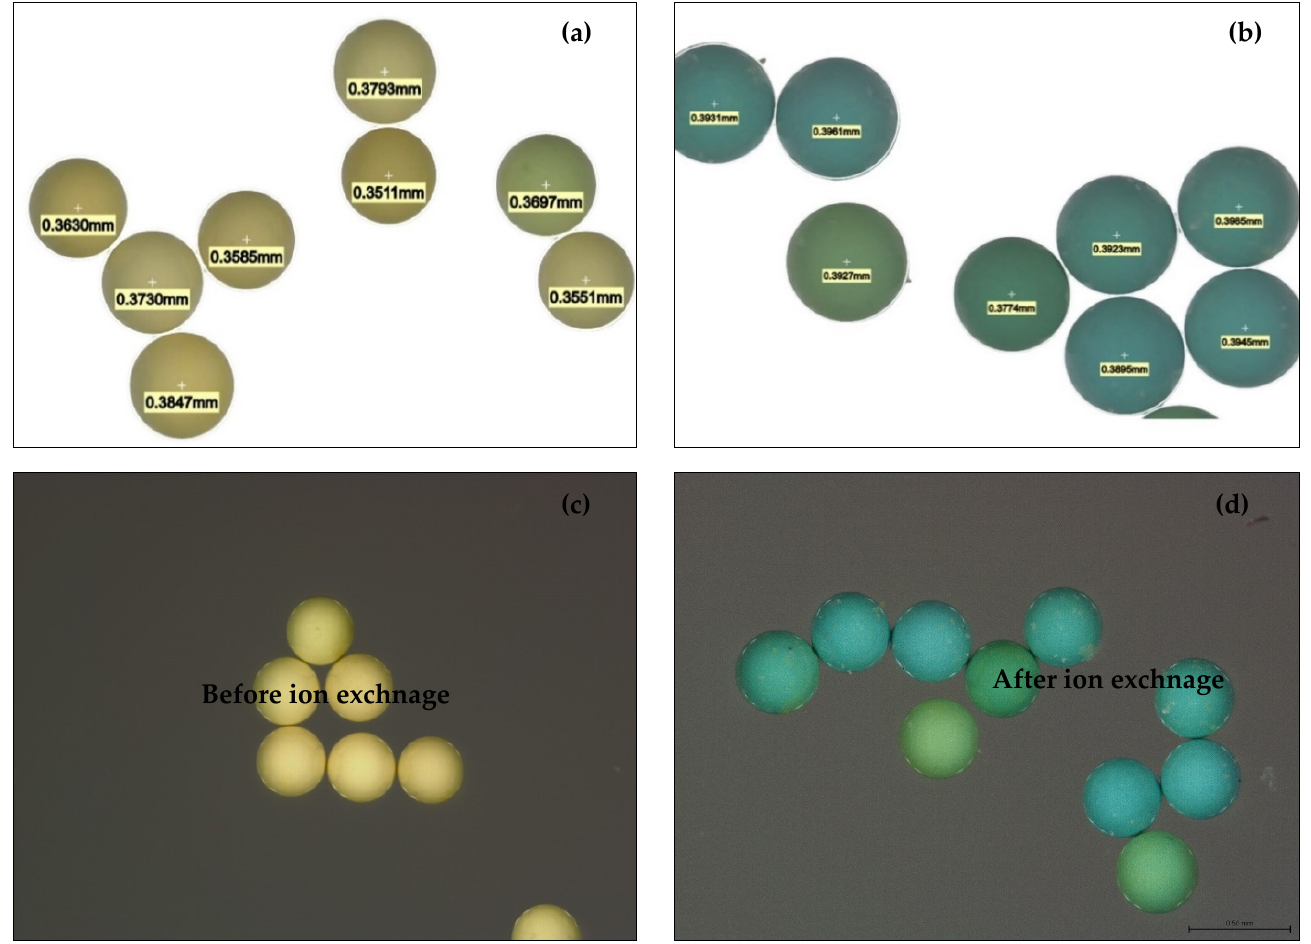
Figure 3. Leica microscope images: ( a ) dimension range of H + Dowex-M4195, ( b ) dimension range of Cu(II)-loaded H + Dowex-M4195, ( c ) H + Dowex-M4195 chelating resin, ( d ) Cu(II)-loaded H + Dowex-M4195.